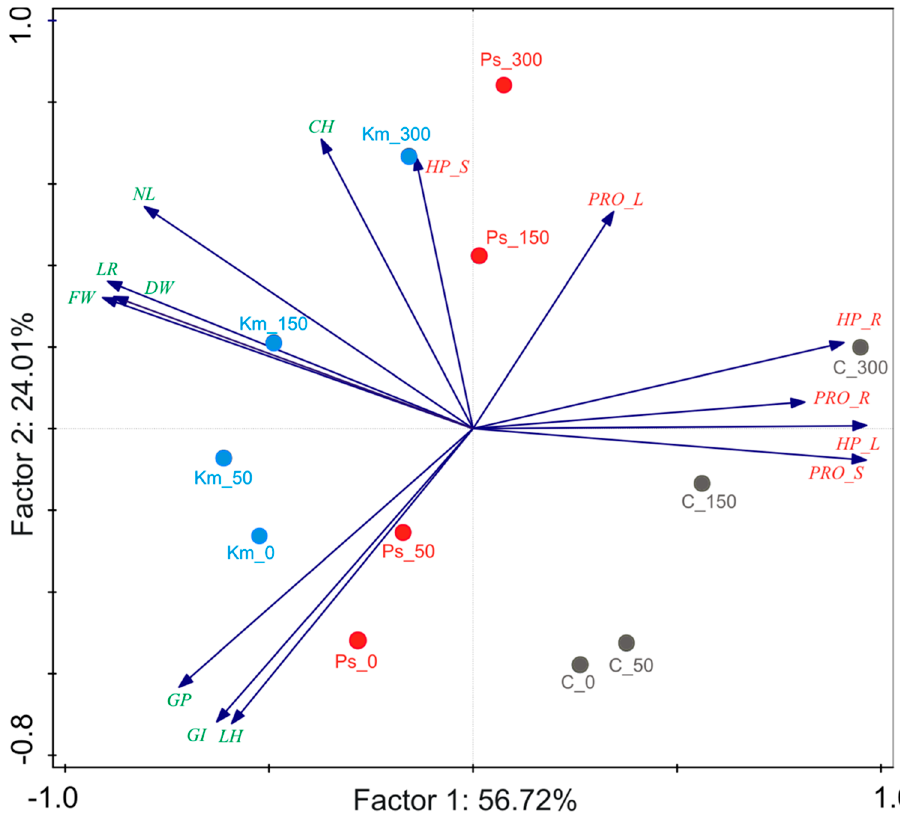
Figure 5. Principal component analysis (PCA) ordination of growth and biochemical parameters of noninoculated (C) and inoculated with P. stutzeri ISE12 (Ps) and K. marisflavi CSE9 (Km) B. vulgaris cultivated at different NaCl concentrations (0, 50, 150, 300 mM NaCl). Abbreviations: GP: germination